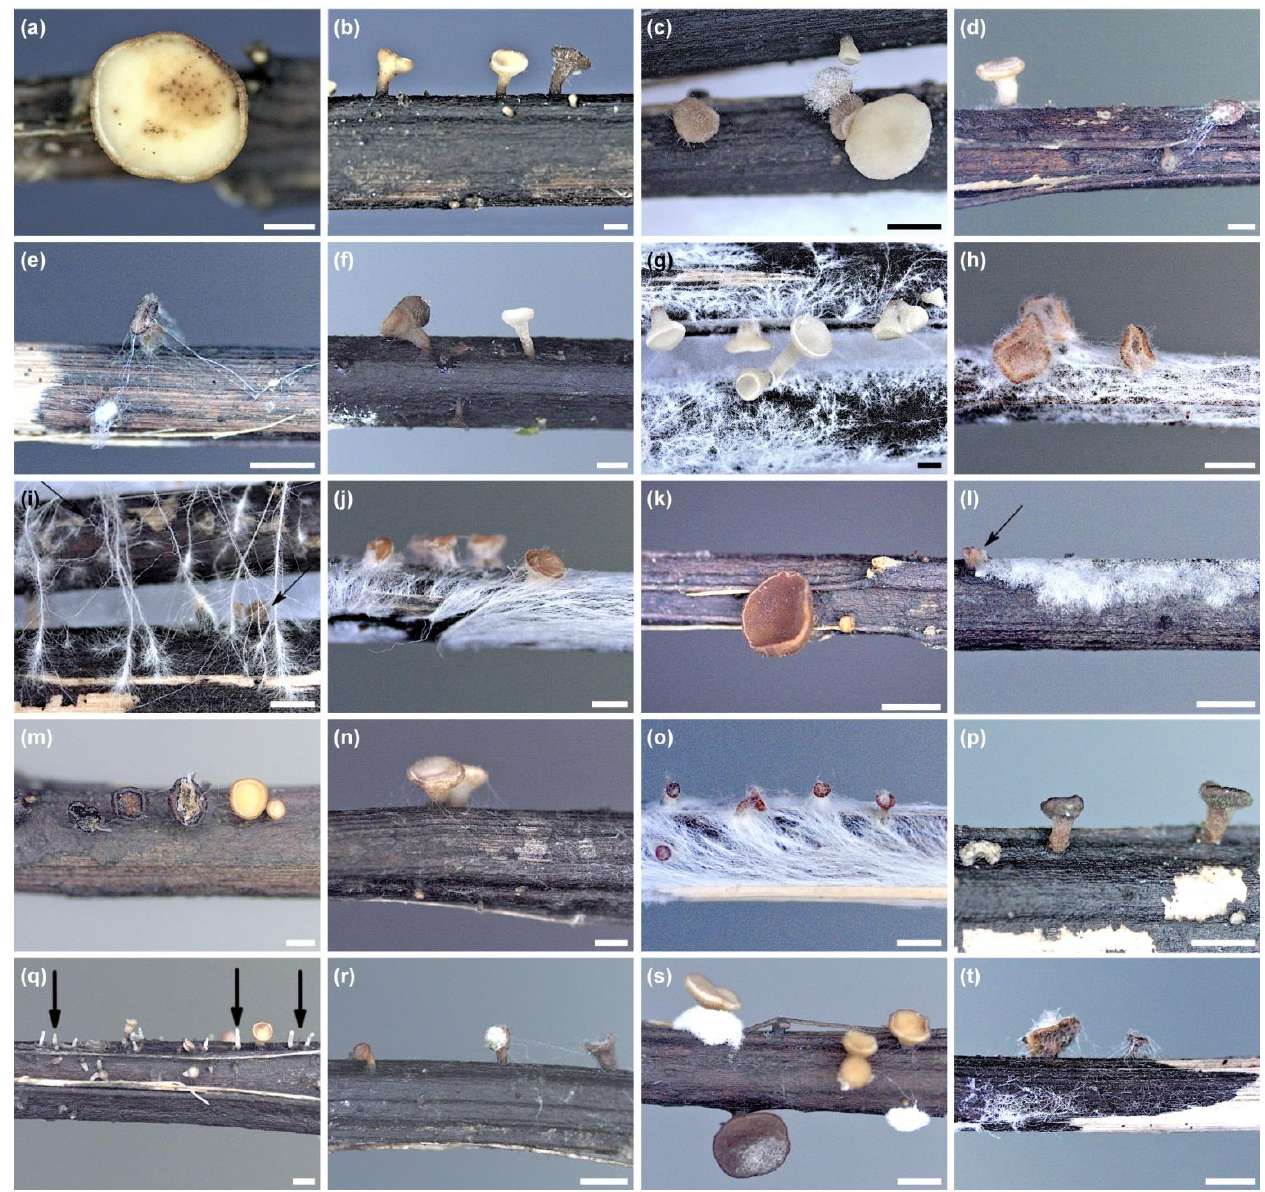
Figure 5. Symptoms of colonization of pseudosclerotial plates and apothecia of H. fraxineus for up to three weeks after inoculation of ash petioles with test fungi: ( a ) Clonostachys rosea Fe213F, ( b ) Clonostachys rosea Fe886F, ( c ) Clonostachys solani Fe26K, ( d ) Cordyceps sp. 1 Fe446K, ( e ) Cordyceps sp. 1 Fe842F, ( f ) Corticiales sp. 1 Fe18K, ( g ) Cyathus olla Fe141F, ( h ) Cyathus olla Fe141F, ( i ) Efibula sp.1